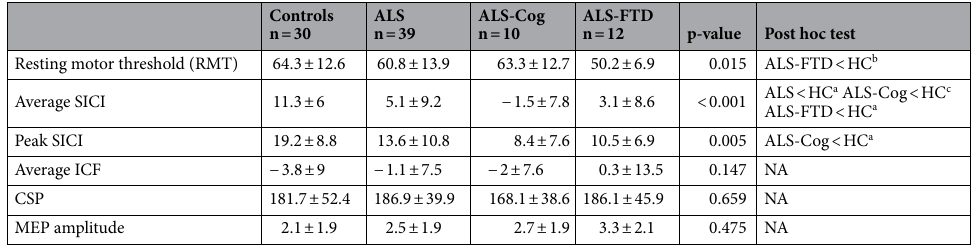
Table 3. Motor cortical function on TMS (mean ± SD). Distribution of motor cortical function across the ALS phenotypes is shown. SICI, short interval intracortical inhibition; ICF, intracortical facilitation; MEP, motor evoked potential; HC, healthy controls. a 0.01 < p < 0.05; b 0.001 < p < 0.01; c p < 0.001, NA = not